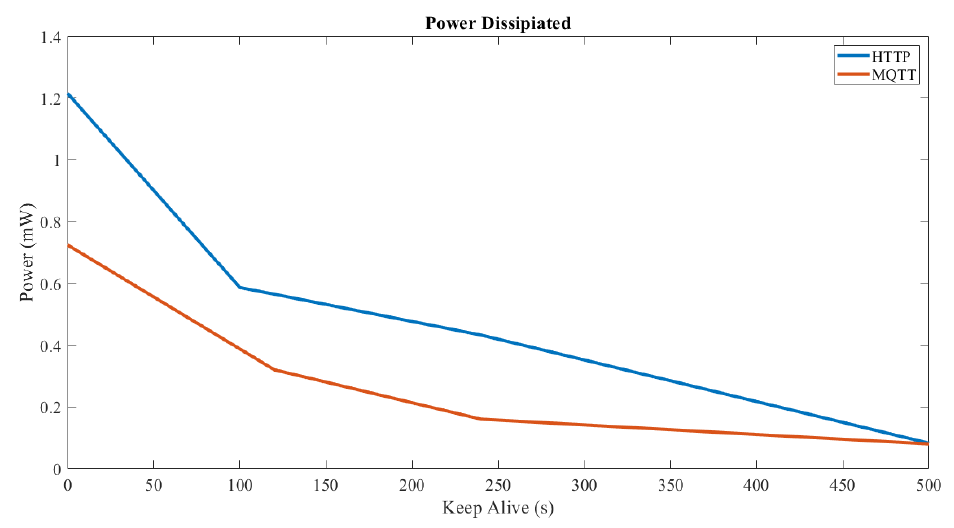
Figure 13. MQTT vs. HTTP—power